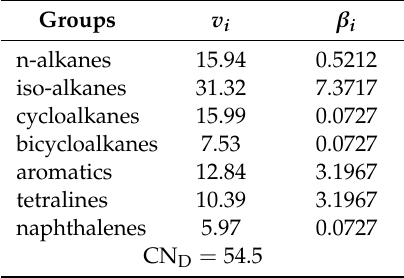
Table 1. The volume fractions and parameters of each group of diesel fuel and their predicted Cetane Number